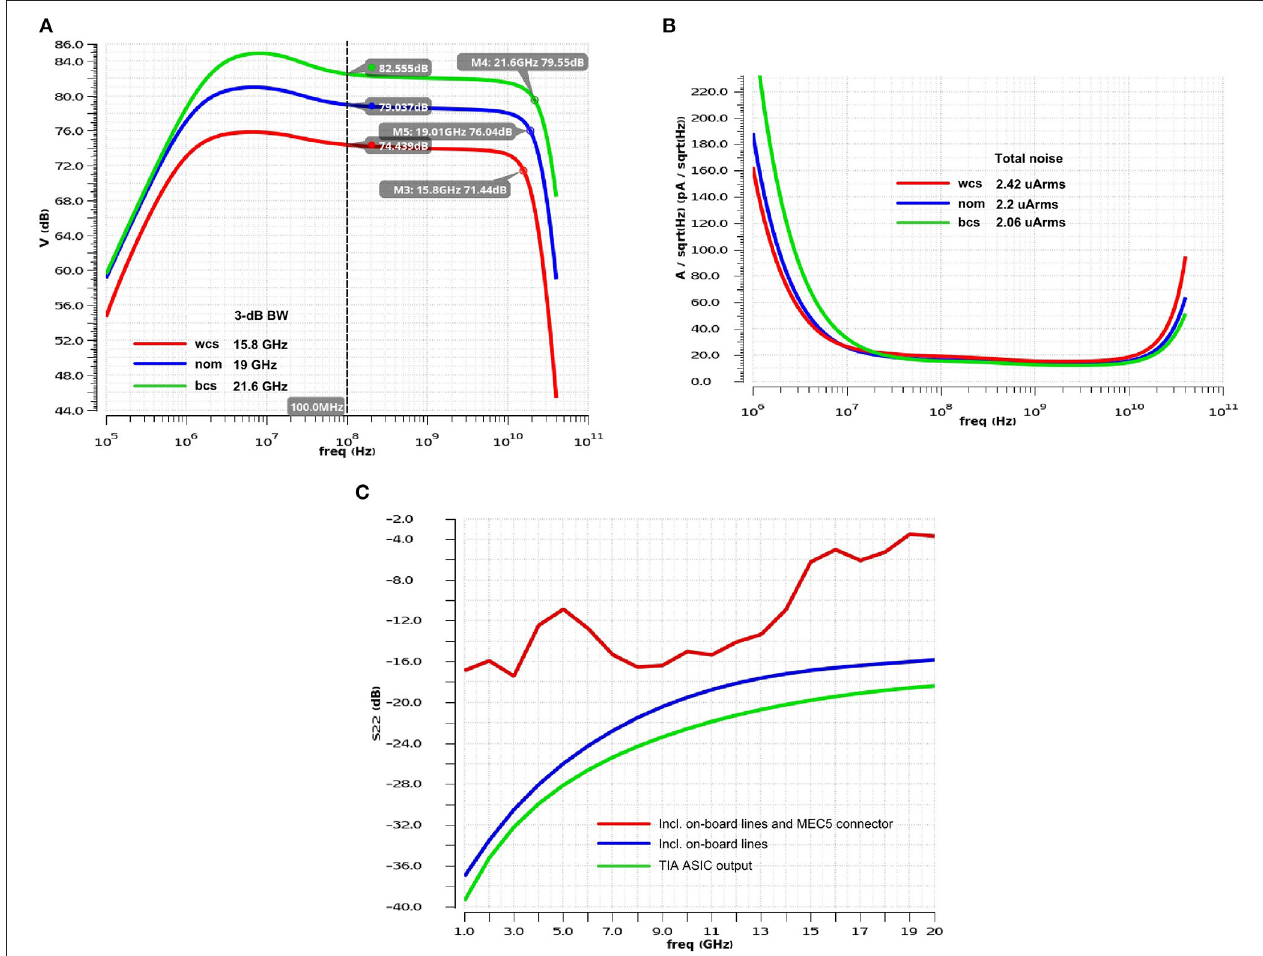
FIGURE 13 | TIA metrics at default SPI register settings and at a 3-V supply voltage: (A) transimpedance gain; (B) input-referred noise current density; (C) TIA ASIC output reflection